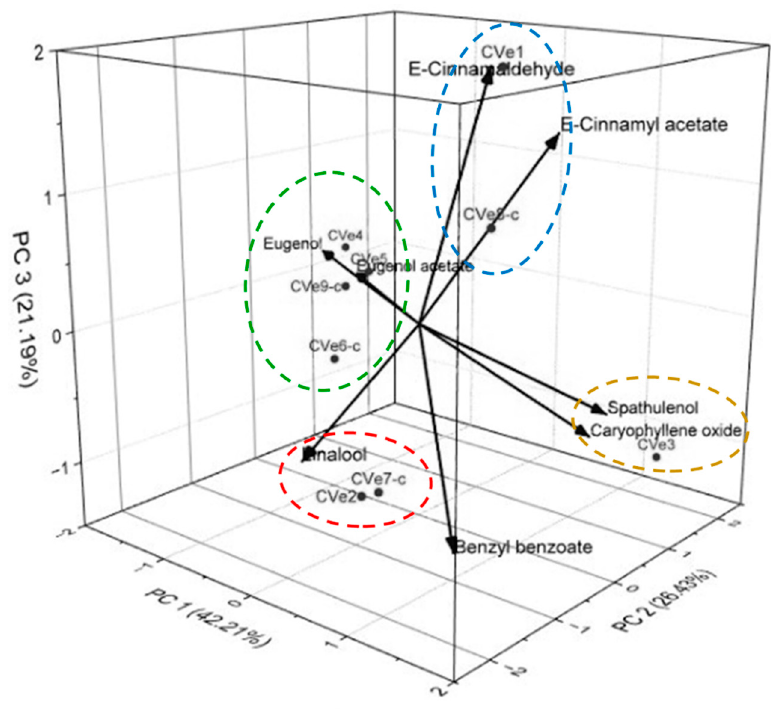
Figure 1. The tridimensional plot of the first three components (PC1, PC2 and PC3) from principal component analysis (PCA) of Cinnamomum verum samples, based on the main constituents present in the analyzed essential oils: cultivated (Cve1-Cve5) and commercial samples (Cv6-c-Cve9-c).